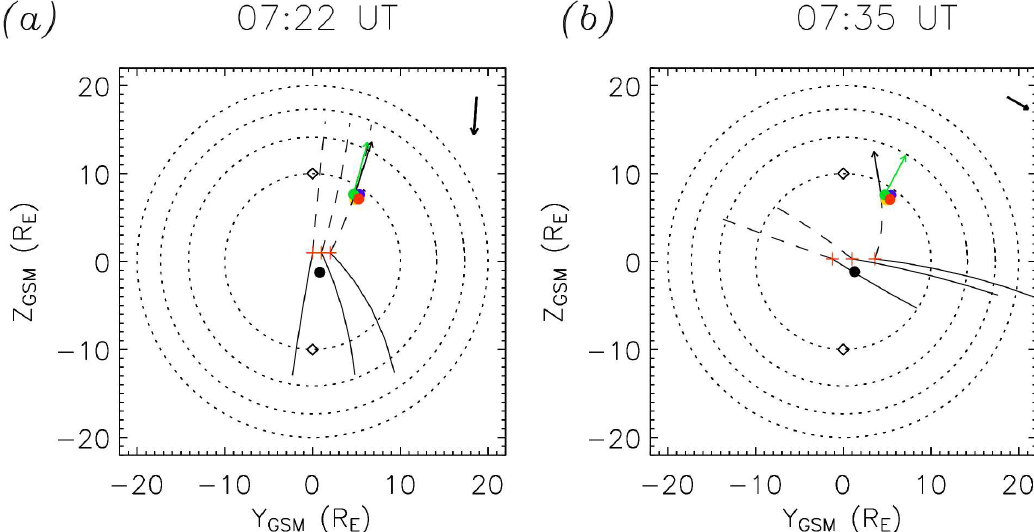
Fig. 8. The simulated path of open magnetic flux tubes over magnetopause derived from the Cooling model. Each panel represents the dayside magnetopause as viewed from the Sun for the IMF direction indicated in the upper right corner. Concentric dotted circles indicate the radius of the magnetopause in the X =+5, 0, − 5, and − 10 R E planes while the location of the cusps are indicated by the diamond symbols. In each panel, reconnection has been initiated at locations indicated by the red crosses. Flux tubes anchored in both the northern (dashed lines) and Southern Hemisphere (solid lines) are traced over 6-min intervals. The Cluster and Geotail spacecraft are indicated by the filled circles, colour-coded as in Fig. 1. The FTE velocity in the Northern Hemisphere, based on multi-spacecraft observations and the estimated open flux tube velocity yielded by the Cooling model, are indicated by the green and black vectors, respectively (scale: 1 R E = 100km s − 1